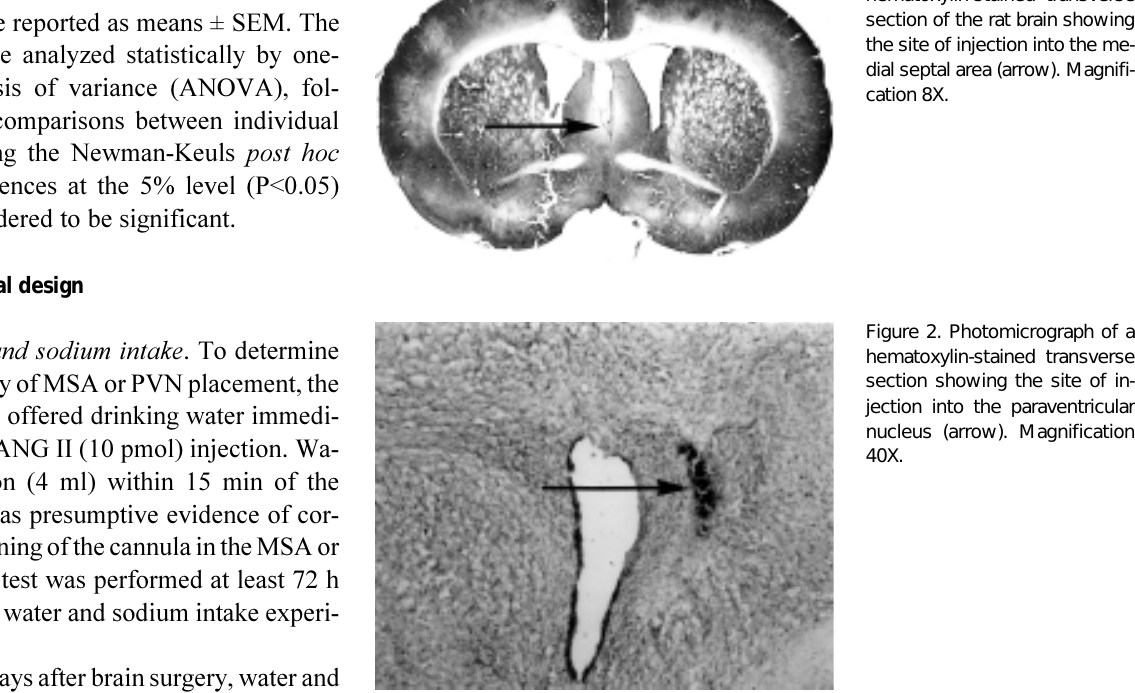
Figure 1. Photomicrograph of a hematoxylin-stained transverse section of the rat brain showing the site of injection into the me- dial septal area (arrow). Magnifi- cation 8X.